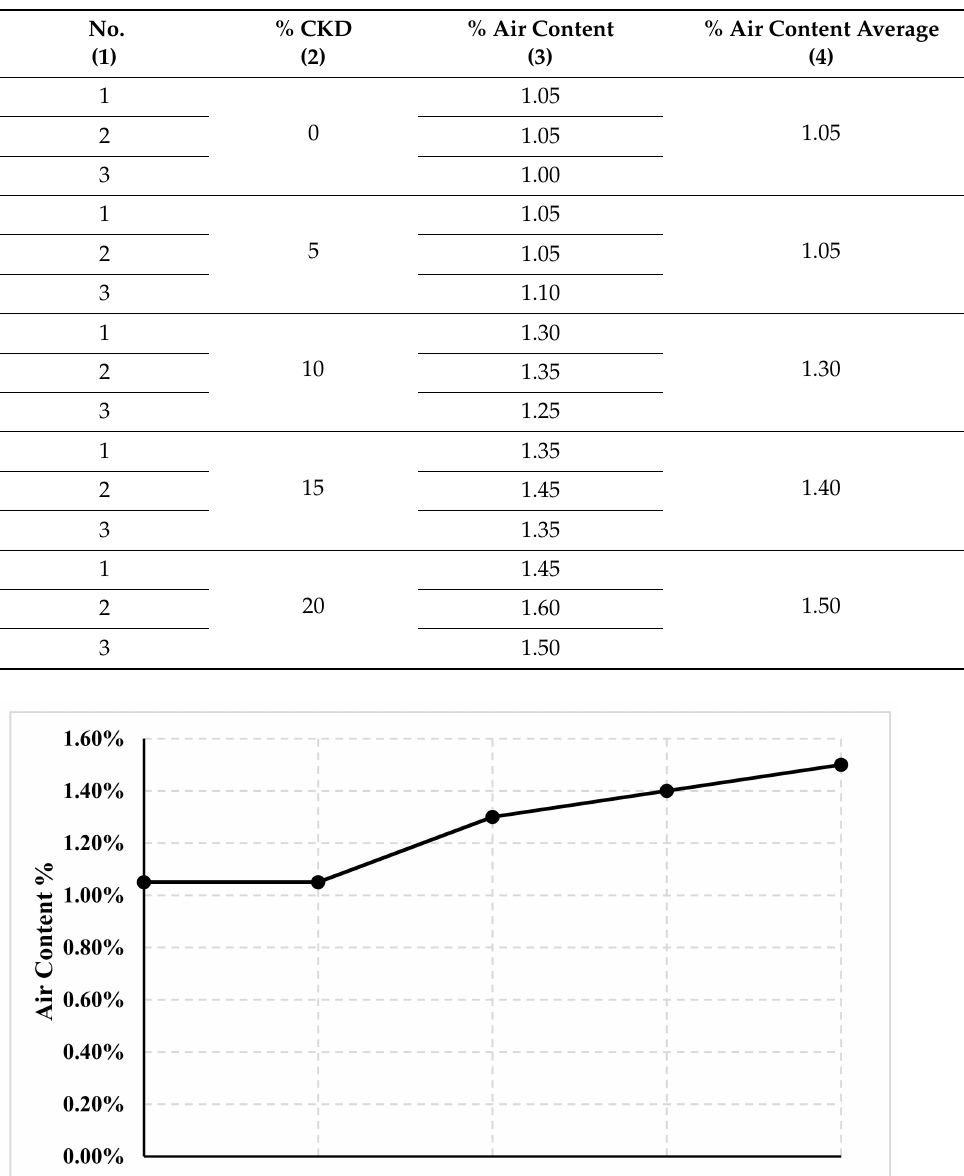
Table 5. Concrete air content results.